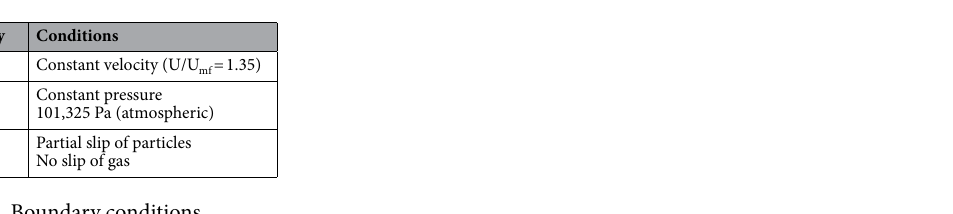
Table 3. Boundary conditions.